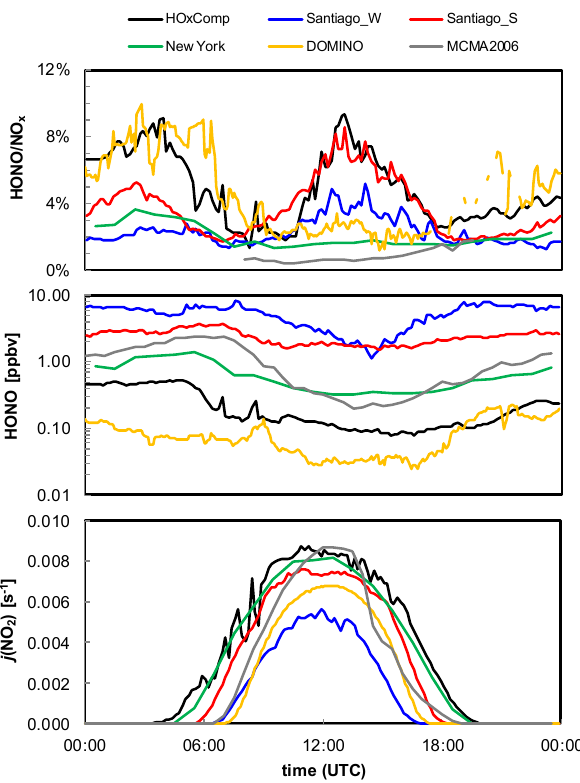
Fig. 1. Diurnal cycles of the HONO/NO x ratio, HONO and j (NO 2 ) Figure 1: Diurnal cycles of the HONO/NO x ratio, j (NO 2 ) and HONO observed in different observed in different field measurement campaigns. For abbrevia- tions and references, see the text. field measurement campaigns. For abbreviations and references, see Table 1 and the text.